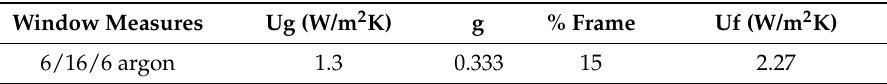
Table 4. Window properties.